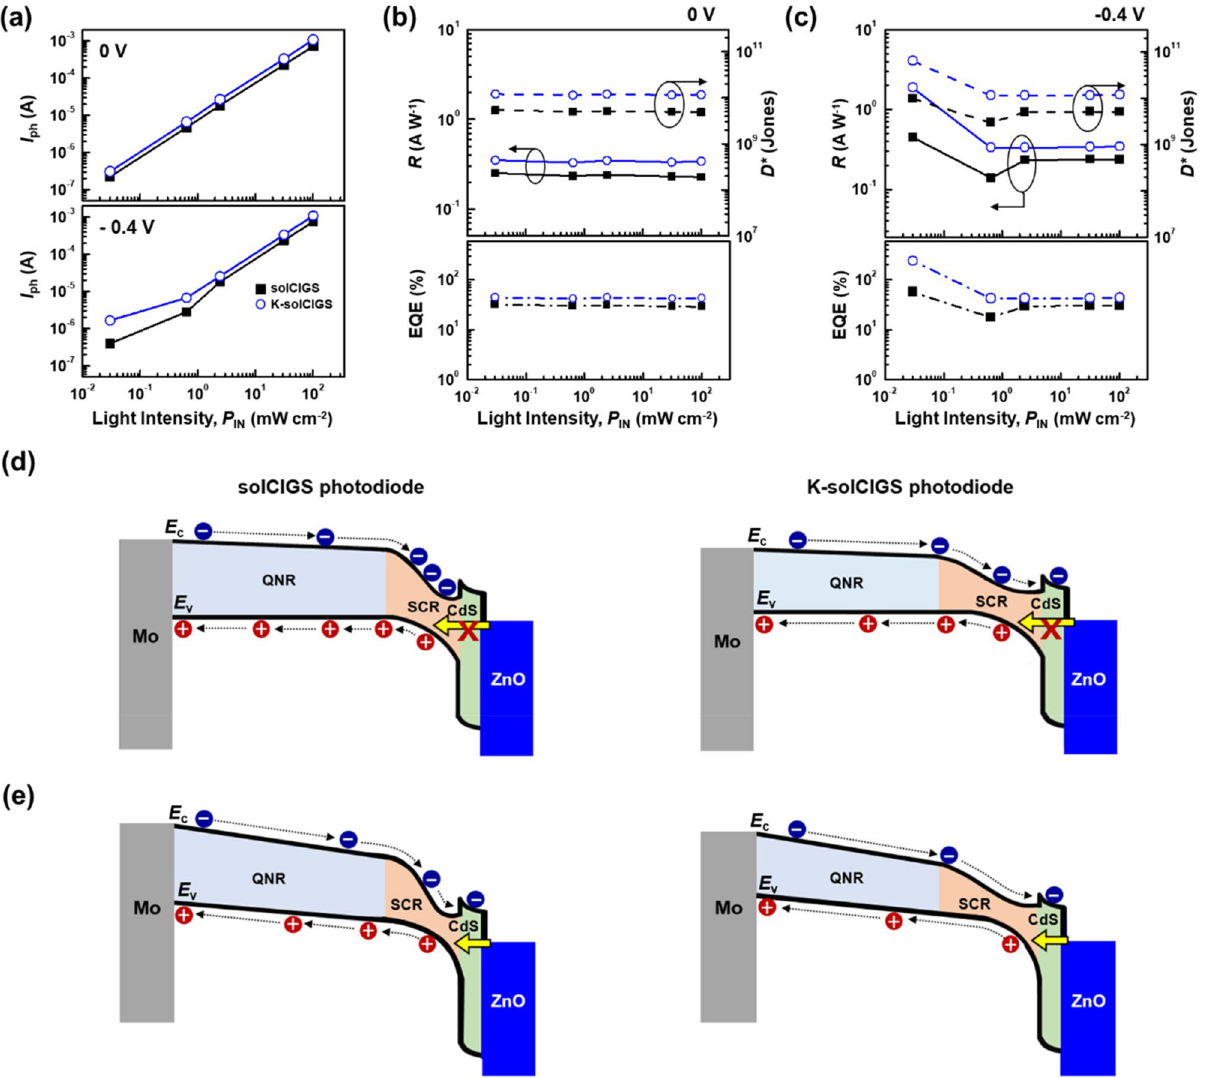
Figure 4. ( a ) Photocurrent ( I ph ) as a function of the light intensity ( P IN ) under NIR wavelength illumination of 980 nm at 0 V and − 0.4 V. ( b , c ) Responsivity ( R ), detectivity ( D * ), and EQE as functions of the light intensity ( P IN ) under NIR wavelength illumination of 980 nm at ( b ) 0 V and ( c ) − 0.4 V. ( d , e ) Schematic energy band diagrams of solCIGS and K-solCIGS photodiodes at low light intensity under ( d ) 0 V and ( e ) − 0.4 V (reverse bias condition). At 0 V, tunneling of hole does not occur. However, at − 0.4 V, holes are allowed to tunnel from ZnO to CIGS, as the yellow arrow